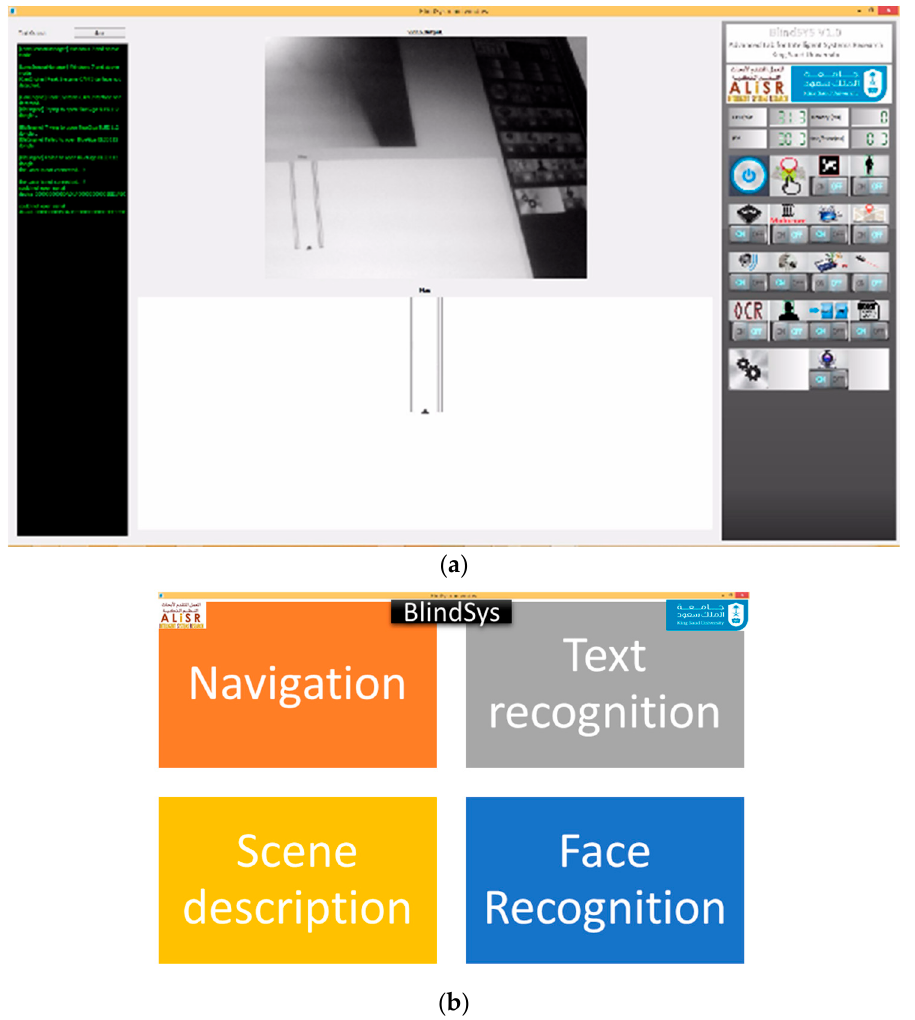
Figure 7. Graphic user interface (GUI) of the prototype implemented to collect dataset images at King Saud University. (a) Detailed GUI for testing and operator support. (b) Simple GUI on the mobile device to be used by the VI.